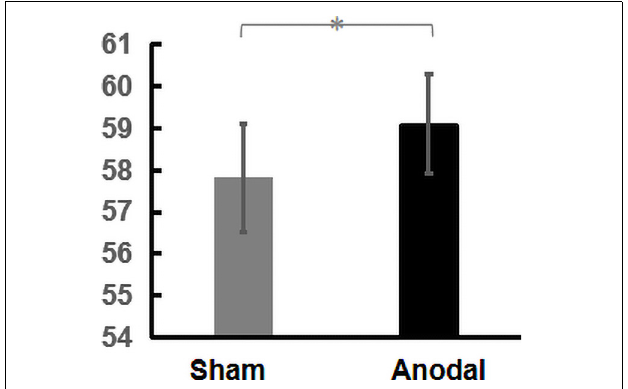
FIGURE 2 | Effect of stimulation on maximization tendency ( ∗ p < 0.05, error bars represent